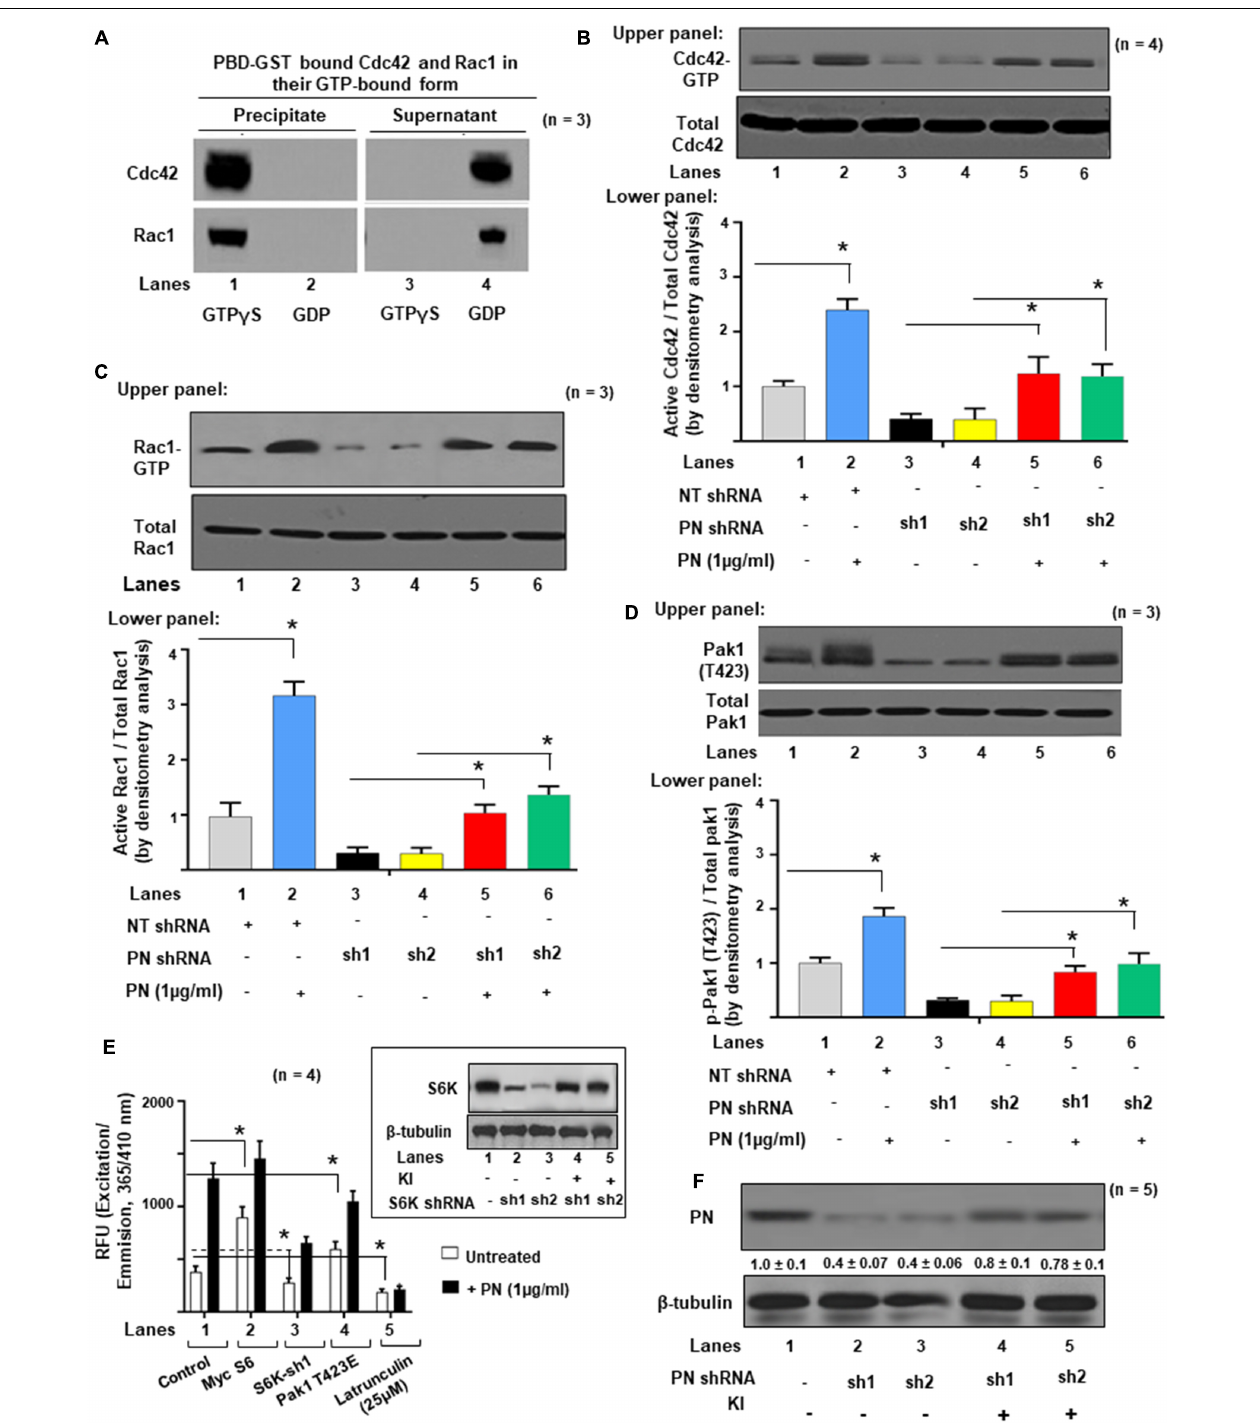
FIGURE 2 | Activations of Cdc42 and Rac1 are associated with Pak1 activation and actin cytoskeletal assembly in VIC ex vivo cultures. (A) Specific interactions of active Rac1-GTP or Cdc42-GTP with GST-fusion protein of GTPase-binding domain (PBD-GST) of human PAK1 wild type (WT, full length) were measured. VIC lysates were incubated with 100 µ M GTP γ S or GDP and clarified before precipitation on PBD-GST beads. Supernatants (S) were separated from bead pellets (P) by centrifugation and analyzed by SDS-PAGE using the indicated antibodies. (B) Upper panel: Transduced VICs with the indicated shRNAs were serum starved for 16 h and incubated without or with 1 µ g/ml PN at 37 ◦ C for 1 h. Cdc42-GTP was pulled-down on GTP-loaded PBD-GST beads. The relative amounts of the activation of small GTPases were quantified by normalizing the amount of bound Cdc42 to total Cdc42 in the lysates. Lower panel: Bars represent densitometric ratios of